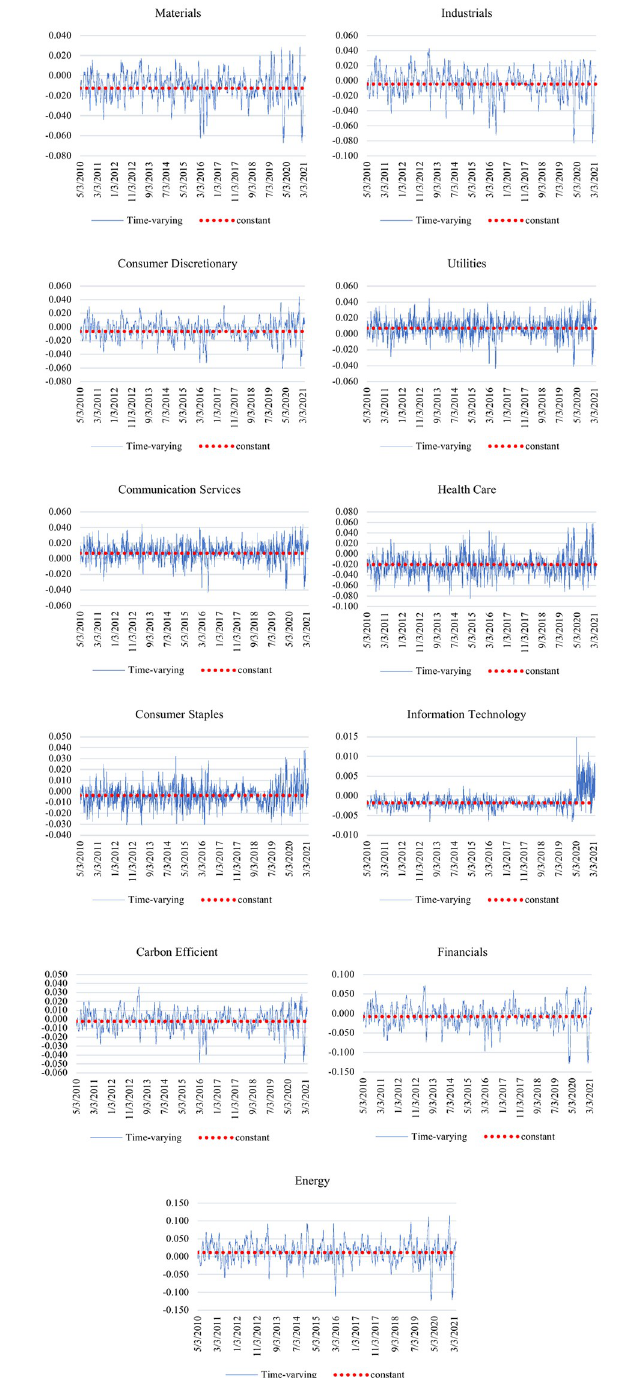
Fig 2. Time-varying and constant normal copula results. This figure shows the results of the normal time-varying copula, implying there is a negative dependency between IEMV and sectoral stock market indices except for communication services and energy sectors. Besides, the health care sector has the highest dependency on IEMV (https://ndownloader.figshare.com/files/29099883).